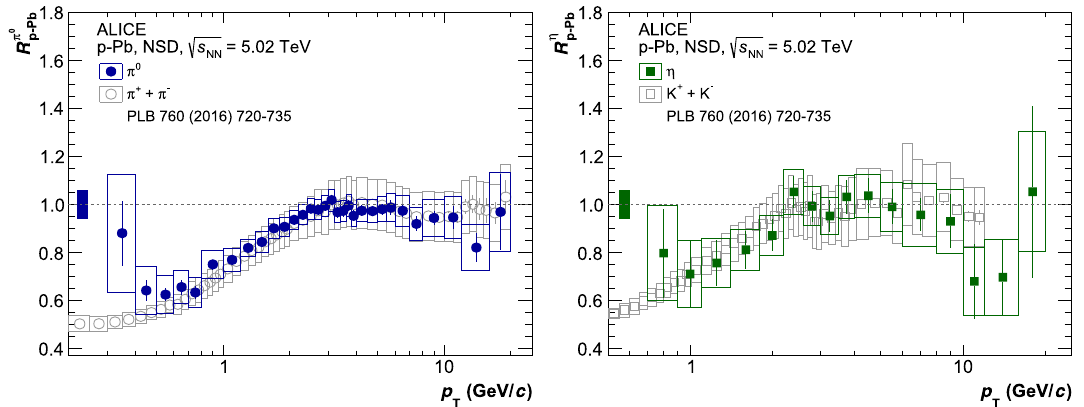
tainties are shown as vertical error bars and the systematic uncertainties are represented as boxes. The overall normalization uncertainty is given as the solid black box around